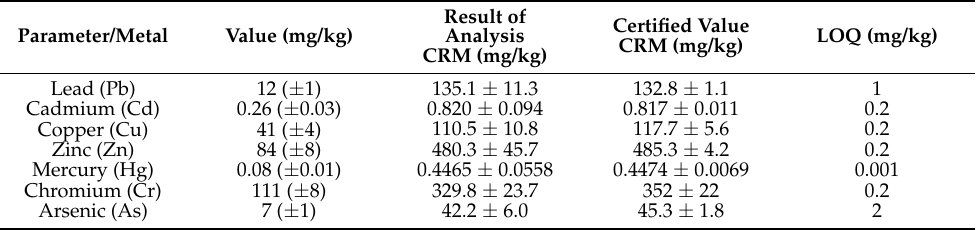
Table 2. Results of metals analysis in sediment from Skadar Lake (near the settlement Vranjina) and in reference material with extended measurement uncertainty (CRM) and limit of quantification (LOQ) of the